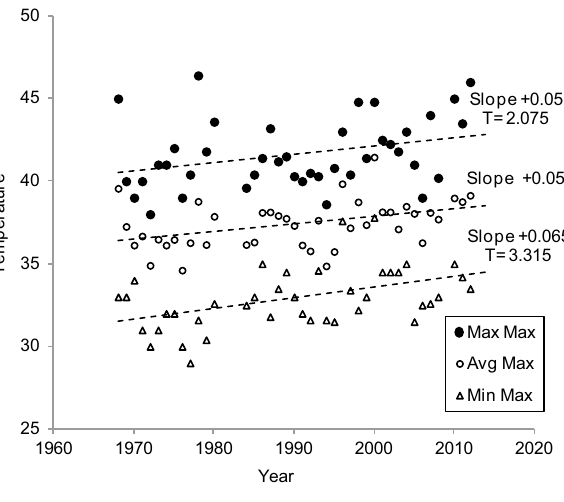
Fig. 2 Monthly maximum temperature in July Al